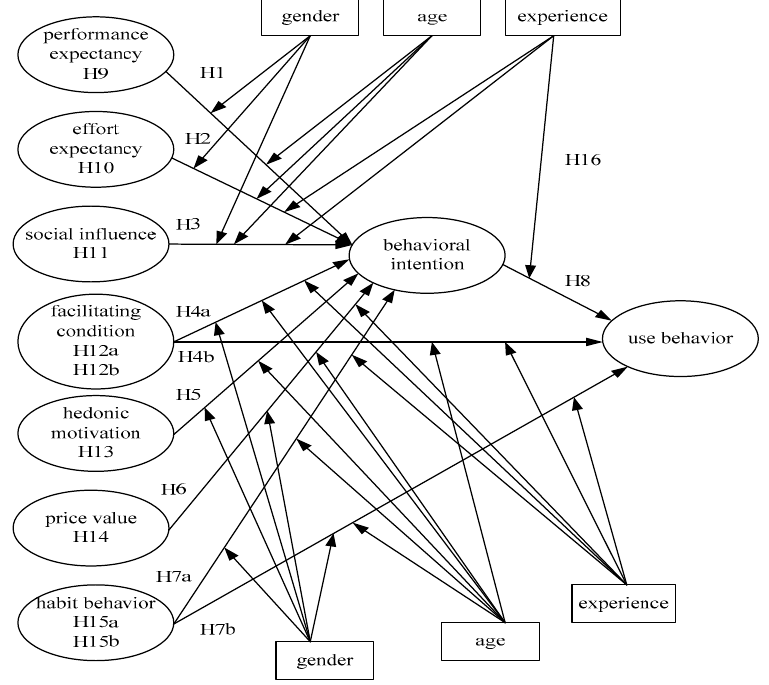
Figure 1. The hypothesized conceptual model of the study.